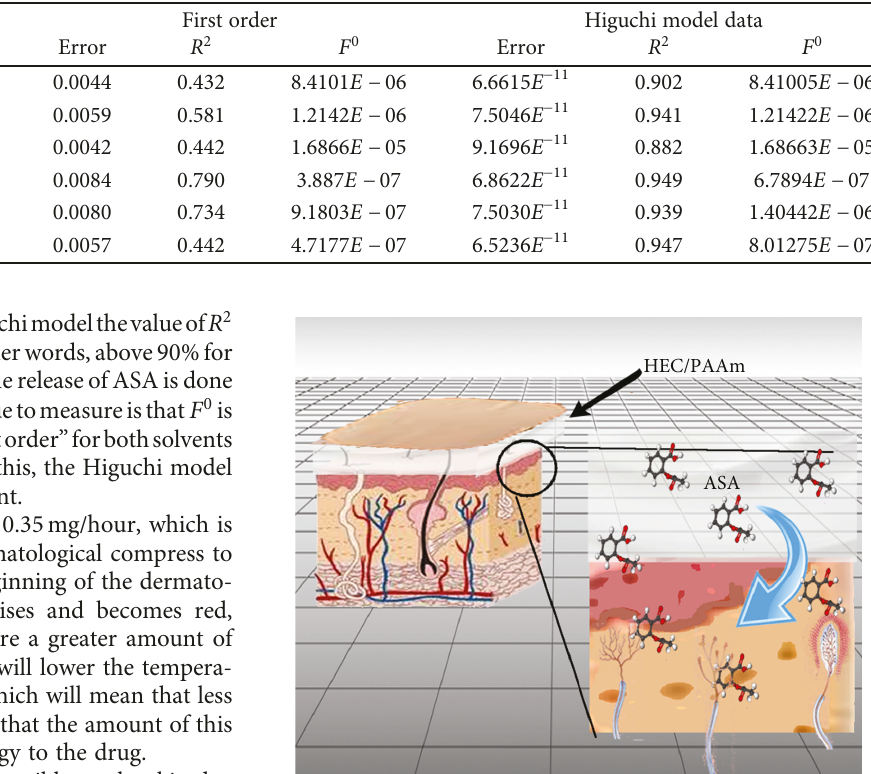
Table 2: ANOVA data from the “ fi rst-order ” equation and Higuchi model simulation.